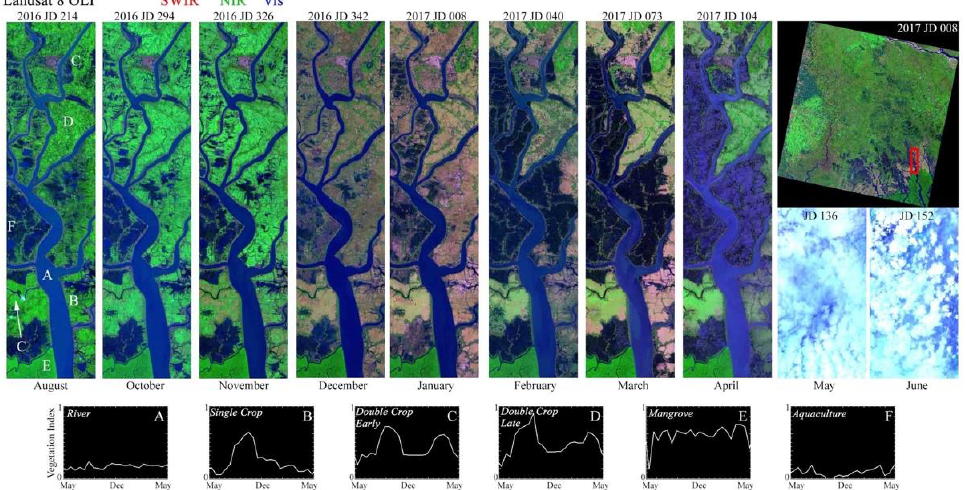
Figure 4. Single year (2016–2017) vegetation phenology on the lower GBD. MODIS 16-day composite EVI pixel profiles show temporal patterns and Landsat 8 OLI false color composites show corresponding spatial detail. A wide range of land uses and phenological patterns are present. Rivers ( A ) and persistent aquaculture ( F ) have similar EVI time series, but can easily be distinguished spatially through a river mask. Note also seasonal changes in river reflectance compared to darker ponds, and the draining of many ponds in December and January. Single crop ( B ) and double crop ( C , D ) agriculture is also present on the lower GBD. Sundarbans mangrove forest ( E ) is evergreen, although sometimes obscured by cloud. Imagery for the subsequent portions of the study was chosen to be in the early dry season (November–December) in order to maximize the contrast between aquaculture and the various agricultural land cover types. All satellite images are false color composites: red = SWIR reflectance; green = NIR reflectance; blue = visible reflectance (Landsat 8 OLI bands 7, 5, and 3).